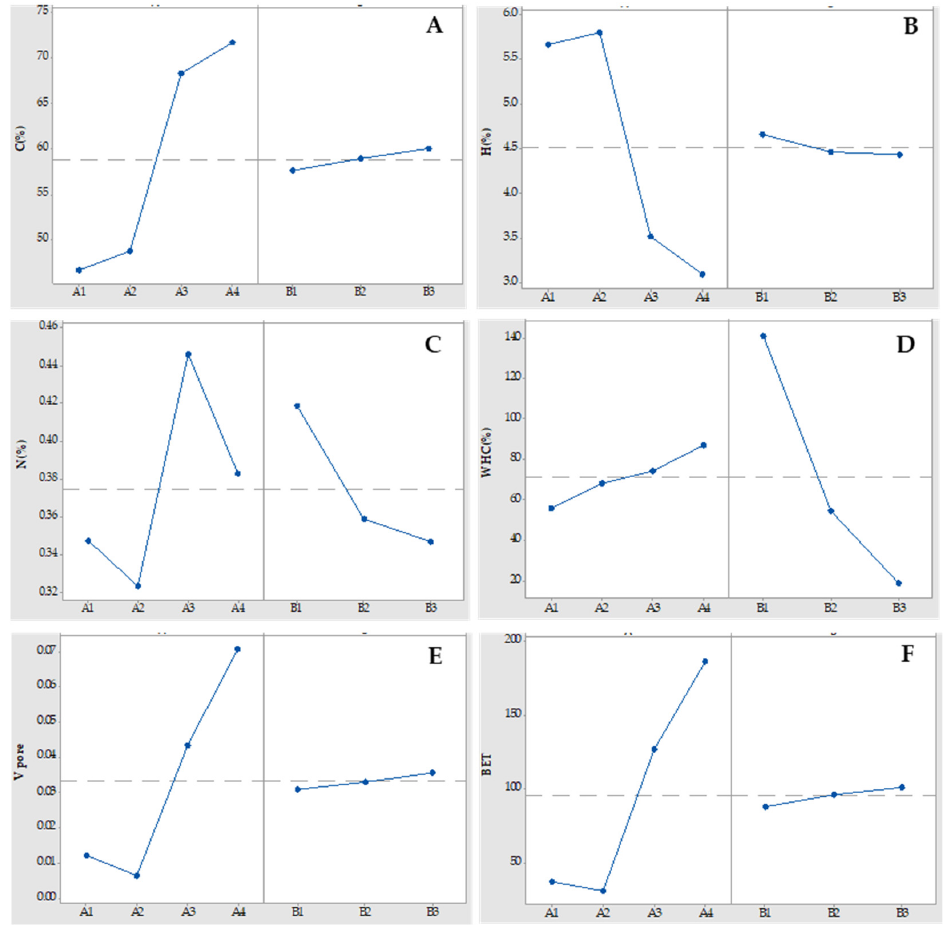
Figure 2. Effects of pyrolysis temperature (A1 = 25 °C, A2 = 200 °C, A3 = 325 °C, A4 = 450 °C) and particle size (B1 = fine, B2 = middle, B3 = coarse) on the elemental composition ( A – C ), the WHC (%) ( D ), the maximum pore volume (cm 3 g − 1 ) ( E ) and the specific surface area (BET (m 2 g − 1 )) ( F ).